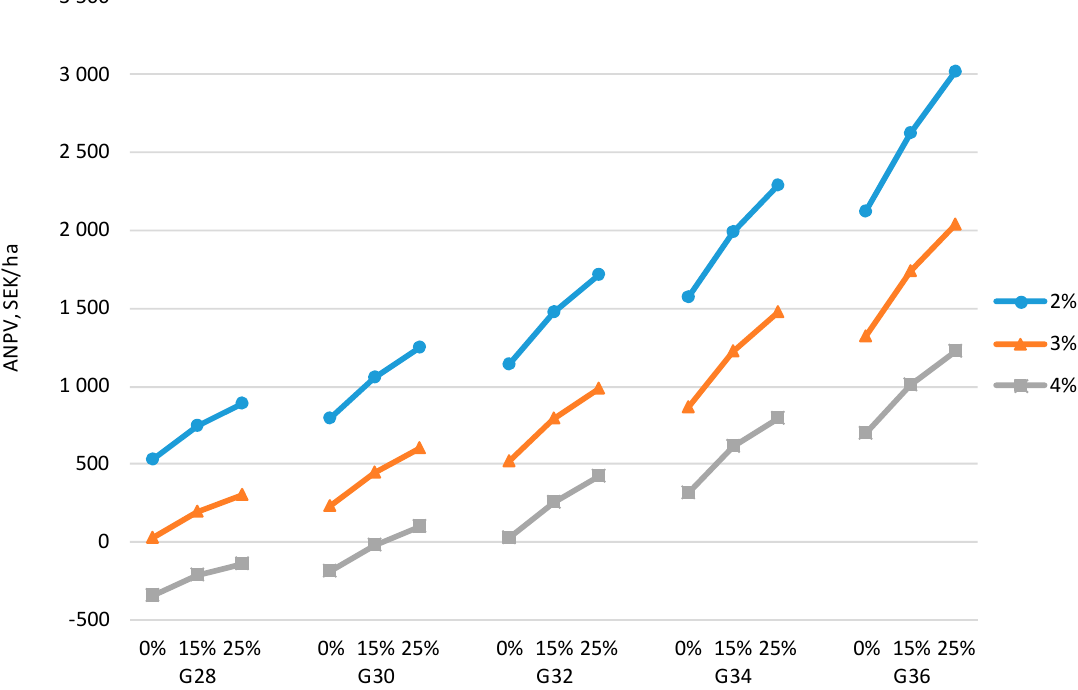
Figure 2. Annuity of net present value (ANPV) (contributions to land, management, and risk; CLM&R) of spruce afforestation of abandoned agricultural land not yet overgrown with shrubs with unimproved seedlings (0%) and genetically improved seedlings growing 15% and 25% faster at site quality classes (SQC) G28–G36 in southern Sweden and at real interest rates of 2%, 3%, and 4%.